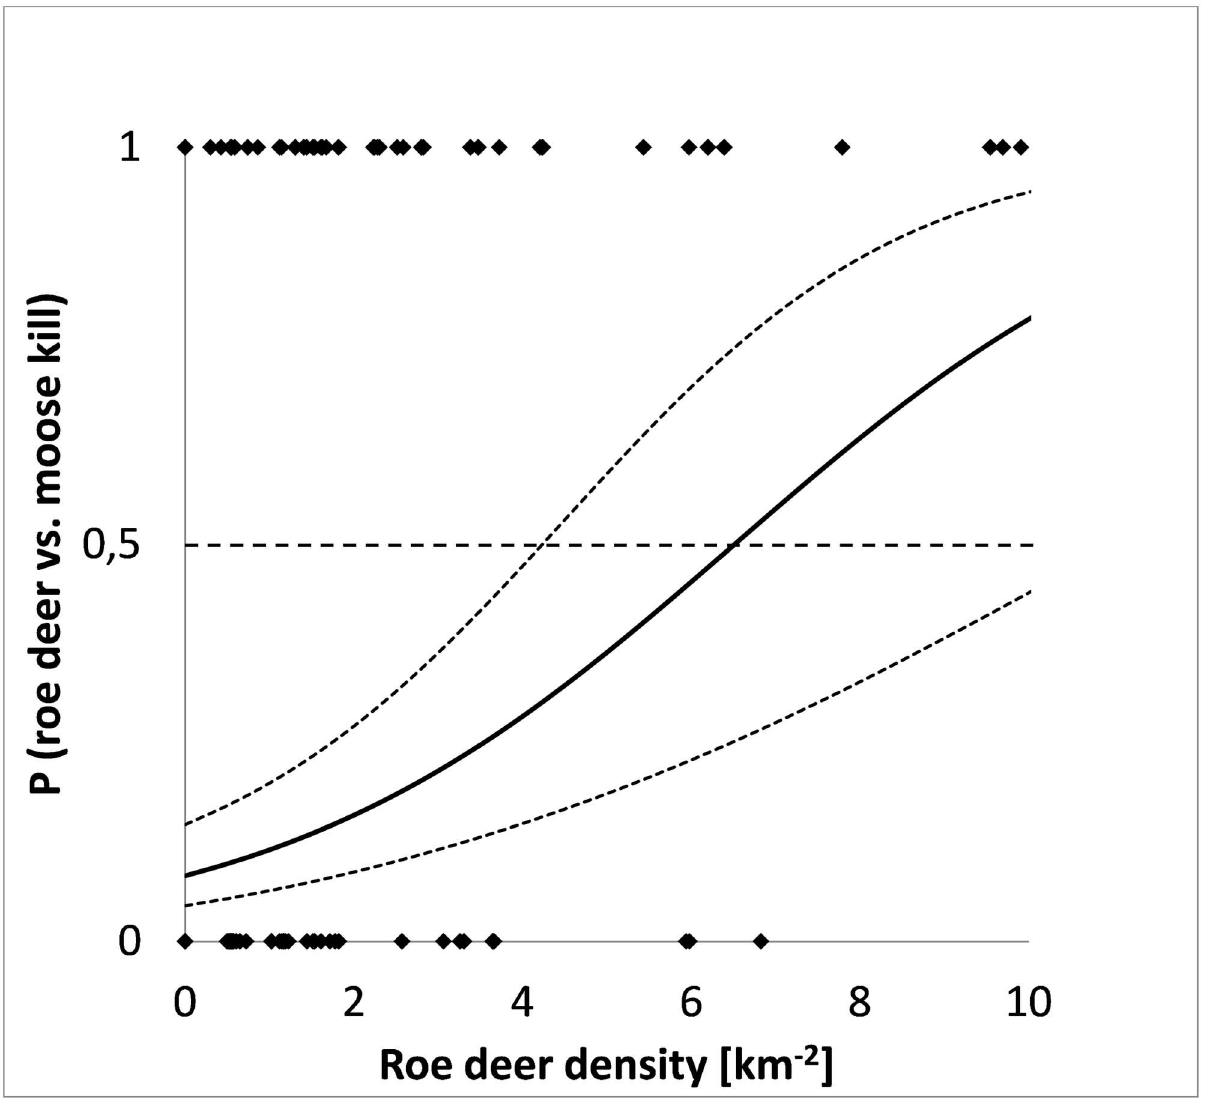
Fig 2. The probability of killing roe deer or moose ( ± SE) by wolves in Scandinavia as related to local (intra-territorial) variation in roe deer density at kill sites (n = 365) at mean moose density (1.8 / km 2 ). The stippledline (Y = 0.5) indicatesequal probabilityfor wolves to kill roe deer or moose. Dots represent either moose kills (Y = 0) or roe deer kills (Y =